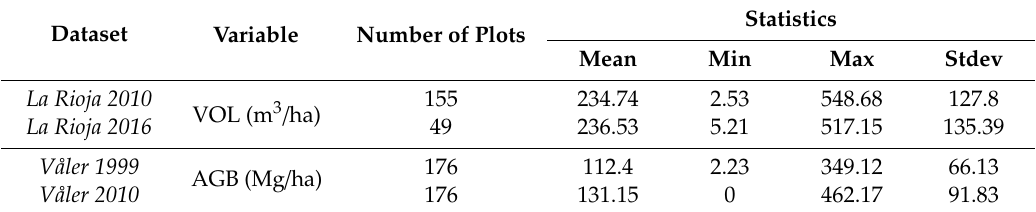
Table 1. Statistics for total volume (VOL) and aboveground biomass (AGB) obtained from the La Rioja sampling designs (La Rioja 2010 and La Rioja 2016) and the Våler sampling